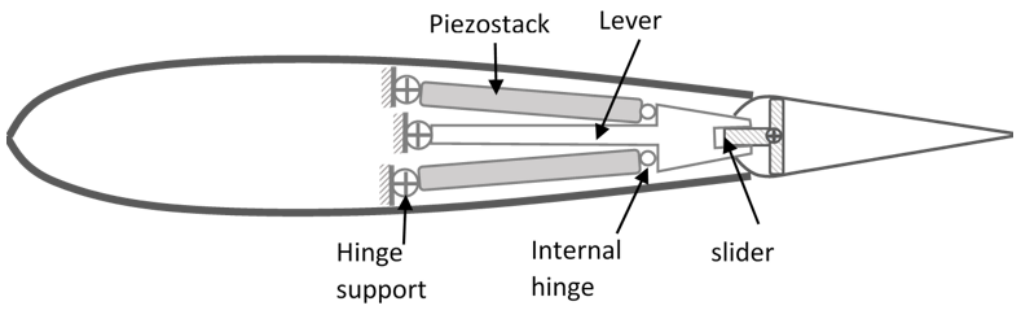
Figure 2. V-stack piezoelectric actuator integrated in the wing structure (adapted from [10]).